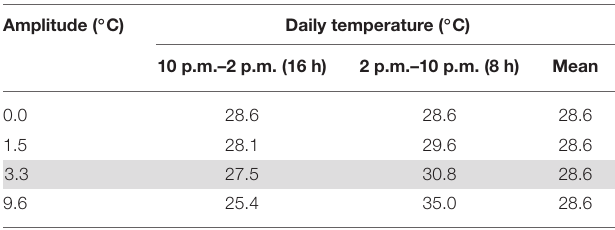
TABLE 1 | Daily fluctuating temperature with different thermal amplitude regimes experienced by the ants during the pupal phase. Amplitude ( ◦